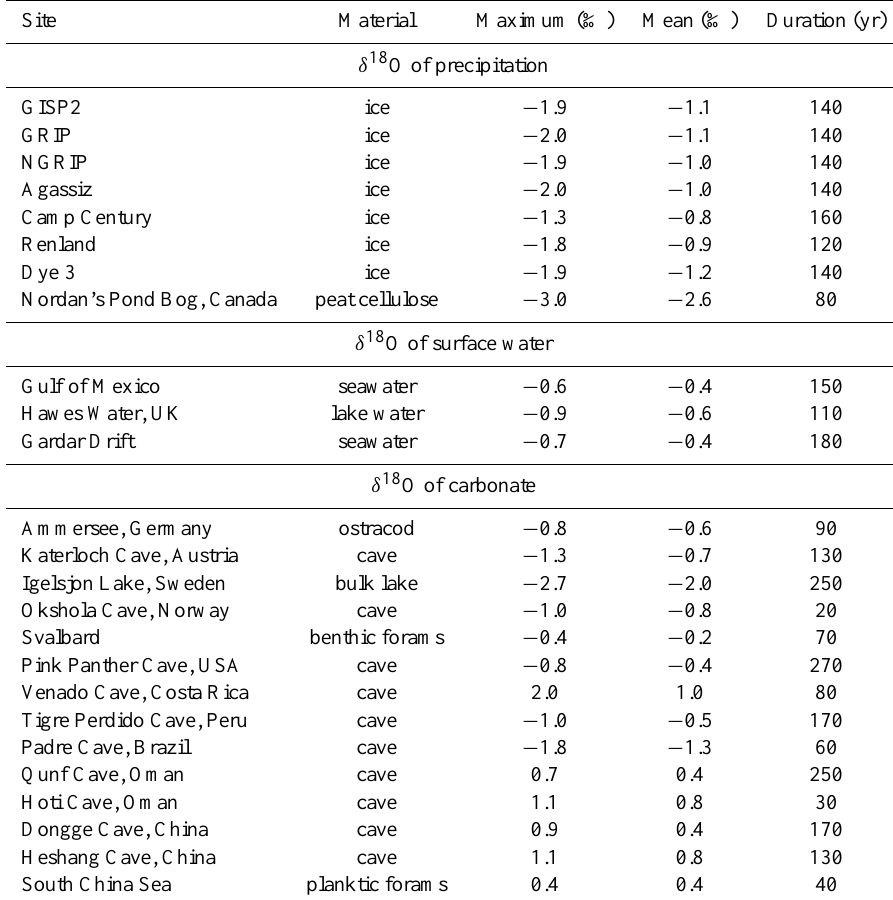
Table 3. Oxygen isotope anomalies from early Holocene background